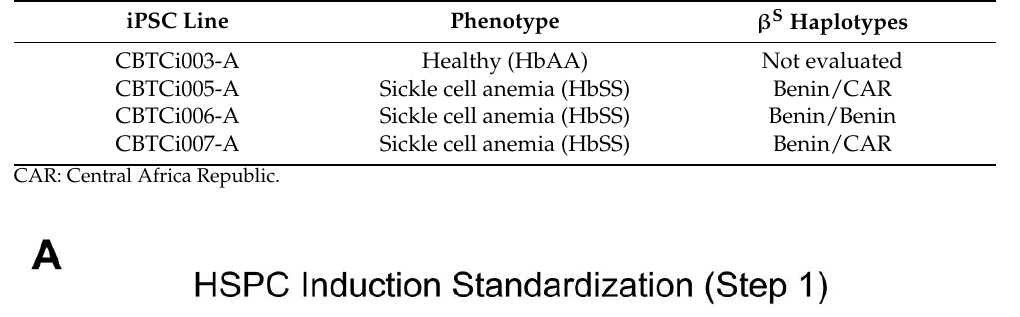
Table 2. iPSC cell line and haplotype identification.